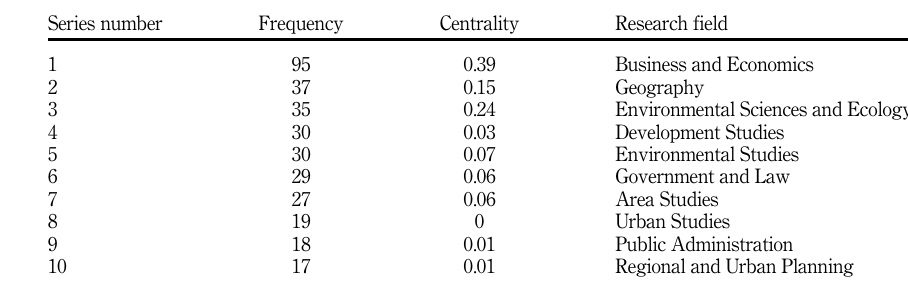
Table 2. Ranking of the disciplines in SEZ research